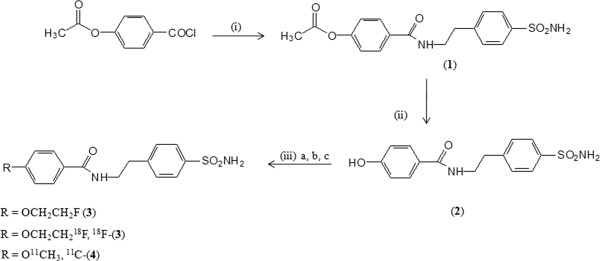
Synthesis of [18F]-(3) and [11C]-(4). Reagents and conditions: (i) AEBS, dichloromethane, pyridine for 72 h at room temperature, (ii) CH3ONa, HCL 1 M, and (iii) (a) DMF, 1-bromo-2-fluoroethane, 70°C, 16 h; (b) DMF, Cs2CO3, 11CH3I, 90°C, 15 min; (c) DMF, Cs2CO3, 18FEtBr, 90°C, 15 min.